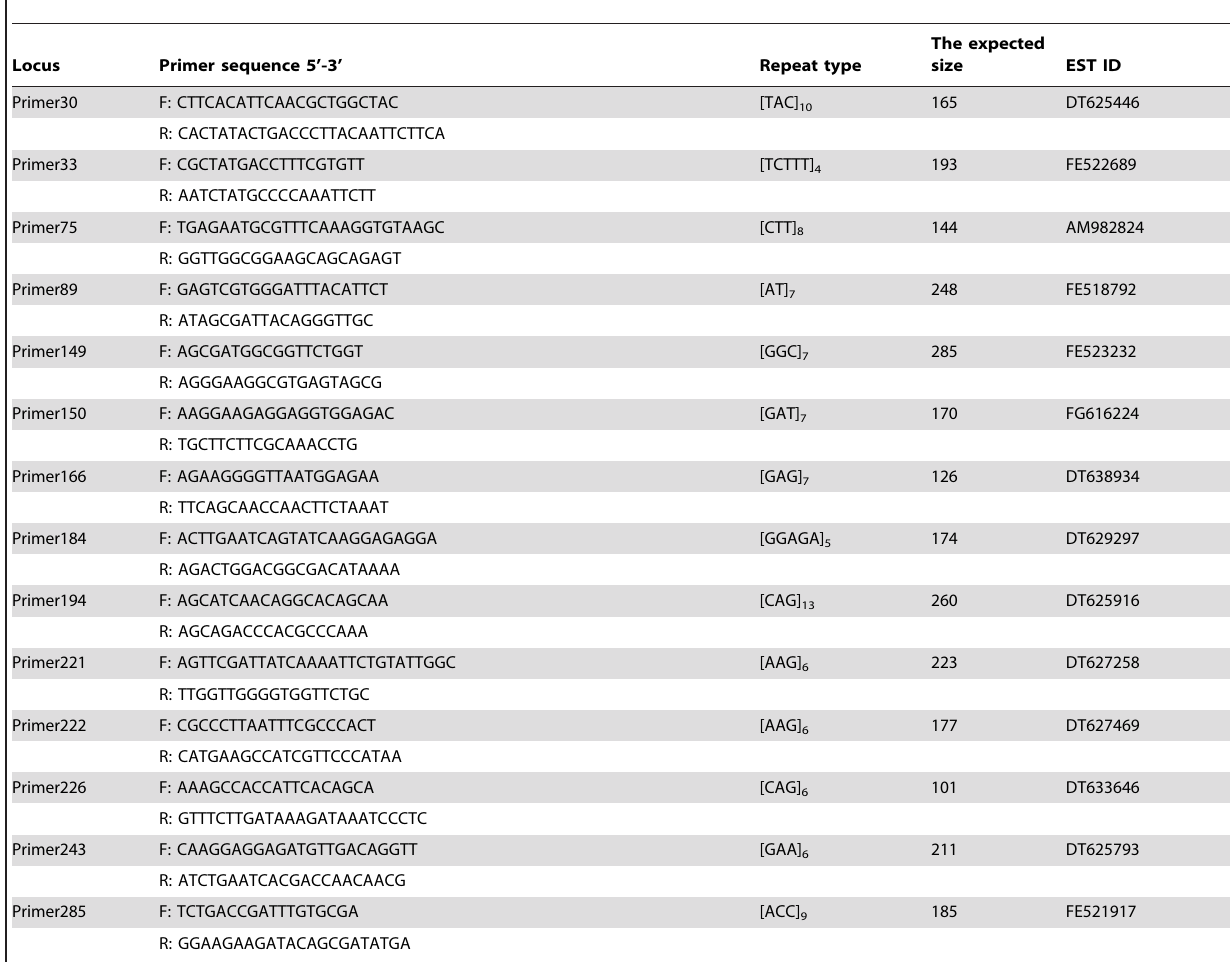
Table 1. Information on the 14 EST-SSR primers used in this study.